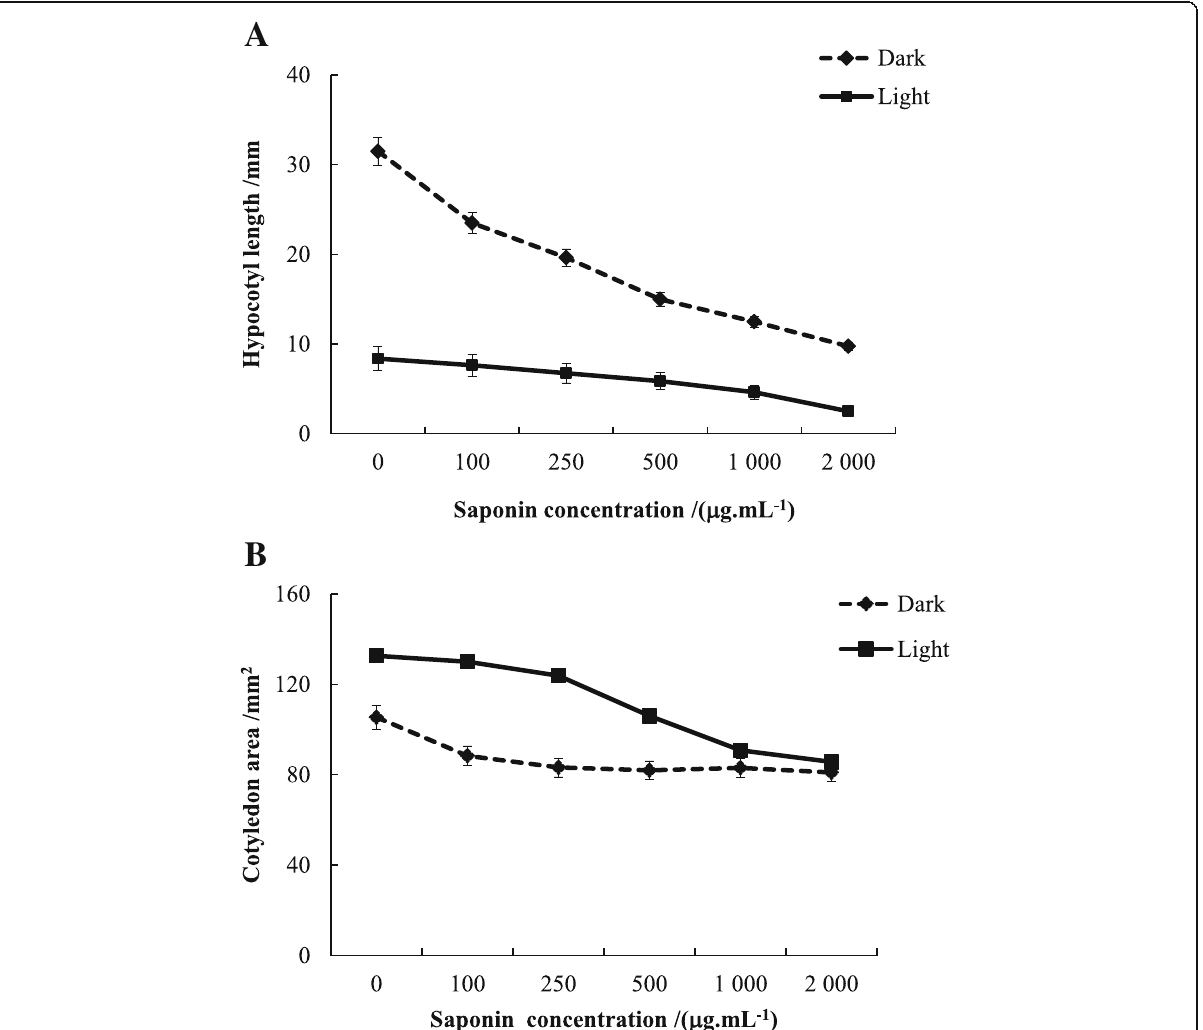
Fig. 7 Effect of saponin (standard) on Amaranthus hypocotyl length ( a ) and cucumber cotyledon expansion ( b ) in dark and in light. The vertical bar indicates ±SE for mean. Values are significantly different at *** P <0.00 1 from filter